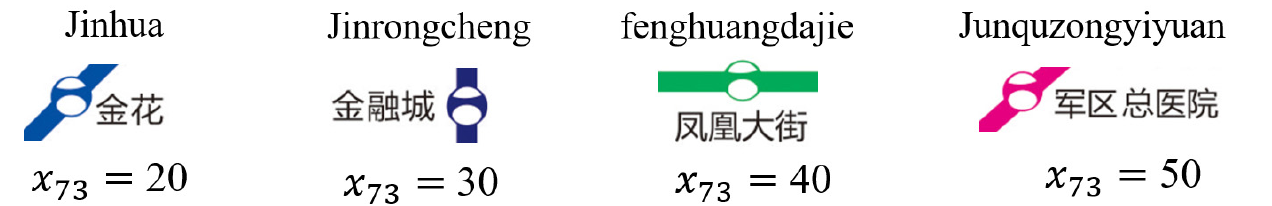
Figure 6. Name labels with different lengths from schematic Chengdu metro map.